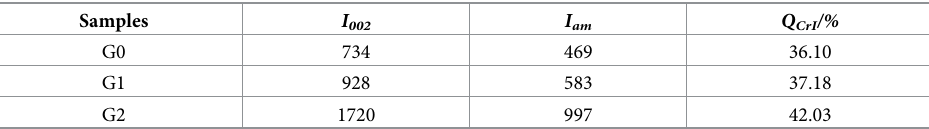
Table 10. XRD crystallinity index of wheat